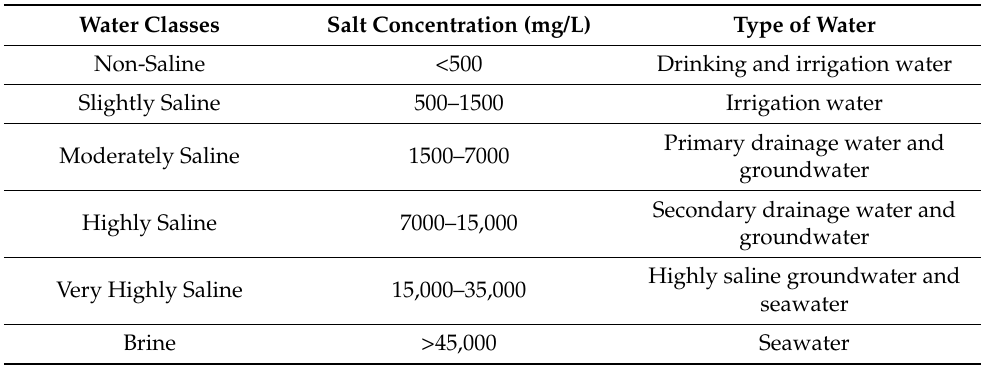
Table 1. Classification of saline waters according to FAO, “Reprinted/adapted with permission from Ref. [23], The use of saline waters for crop production, 1992,